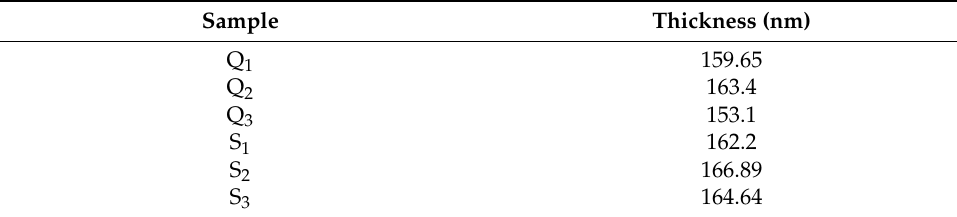
Table 2. Comparison between the experimentally measured thicknesses of the porous ZnO films.